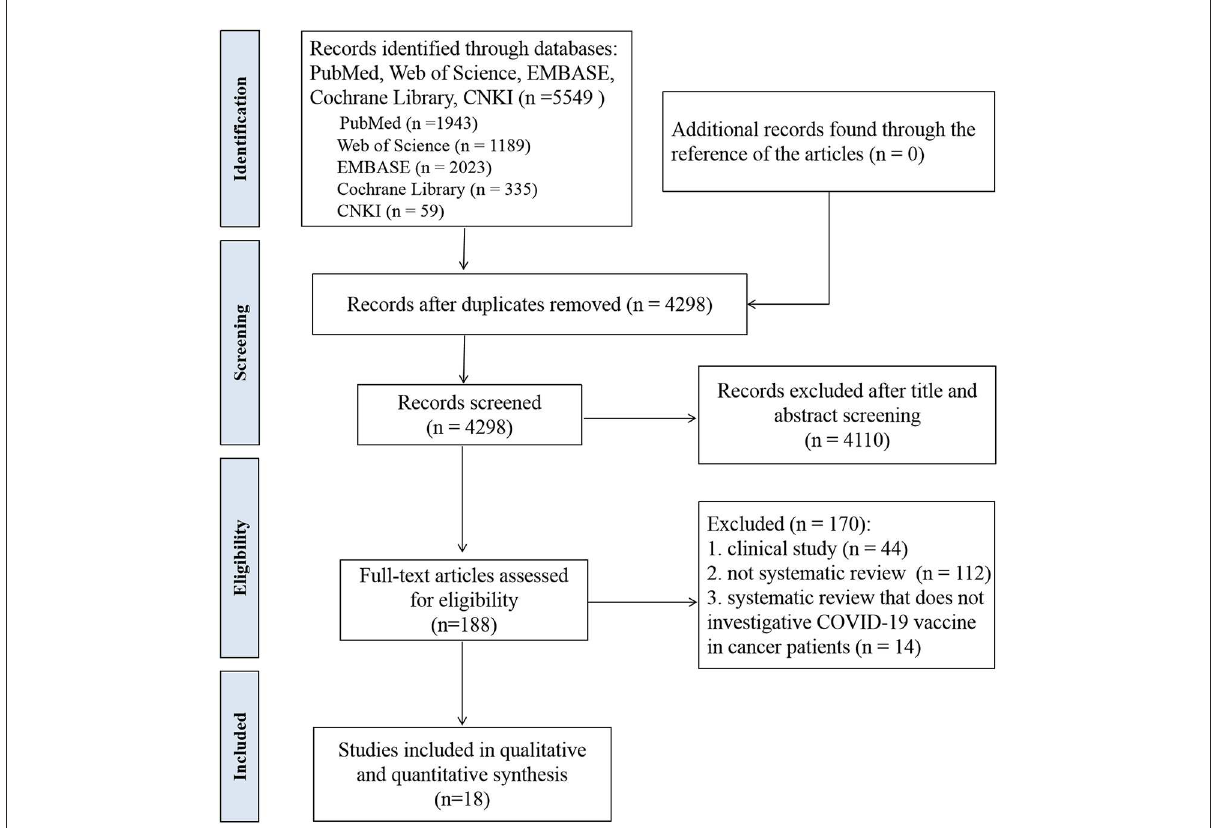
FIGURE2 PRISMA flowchart of the identification and inclusion of systematic reviews.